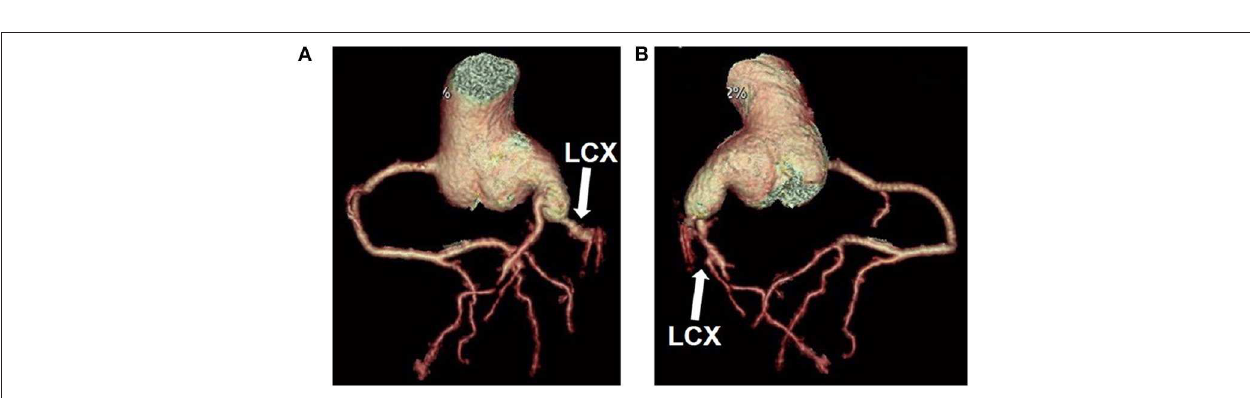
FIGURE 6 | Cardiac computed tomographic showed constriction of the left coronary artery and circumflex artery (A,B) . LCX, left circumflex